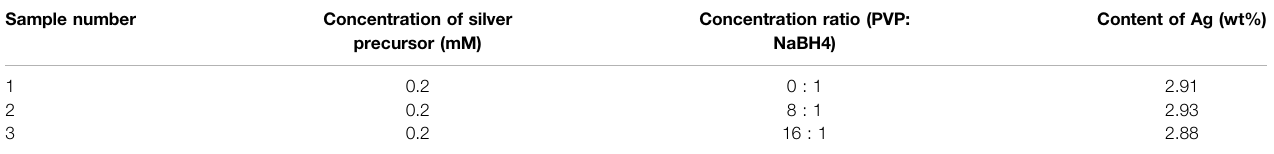
TABLE 4 | Actual loading content of supported nanocatalysts measured by ICP-AES. Sample number Concentration of silver Concentration ratio (PVP: precursor (mM)